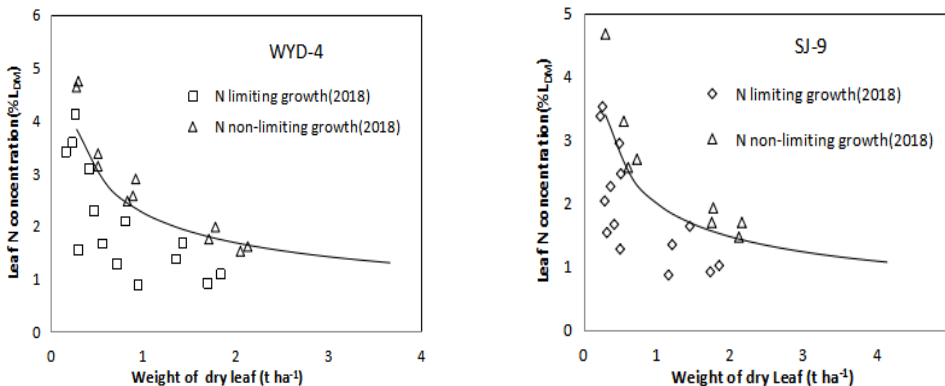
Figure 5. Comprehensive validation of N c dilution curve using independent data set from experiment conducted in 2018. Data points ( (cid:3) ) represent N limiting growth conditions, while ( ∆ ) non-limiting conditions. The solid line in the middle represents the critical N curve (N c = 1.96L DM−0.56 , R 2 = 0.87 for Wuyoudao4; N c = 1.99L DM−0.44 , R 2 = 0.94 for Songjing9) describing the relationship between the critical N concentration and leaf dry matter of rice.